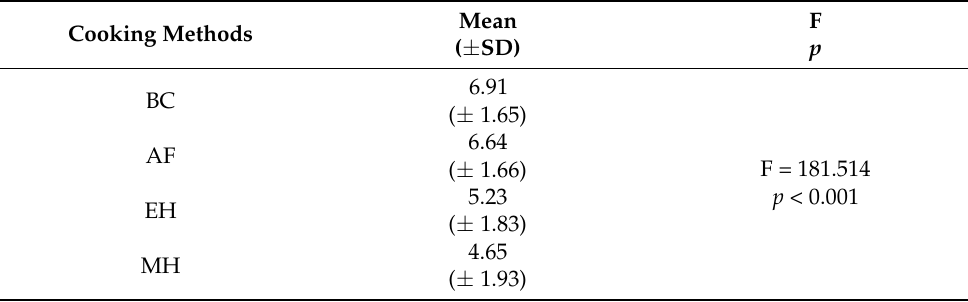
Table 2. Mean overall liking, based on 9-point hedonic scale, ( ± SD) according to the type of grilled lamb shashlik for different cooking methods. F-values from the one-way ANOVA, with different cooking methods as factors on overall